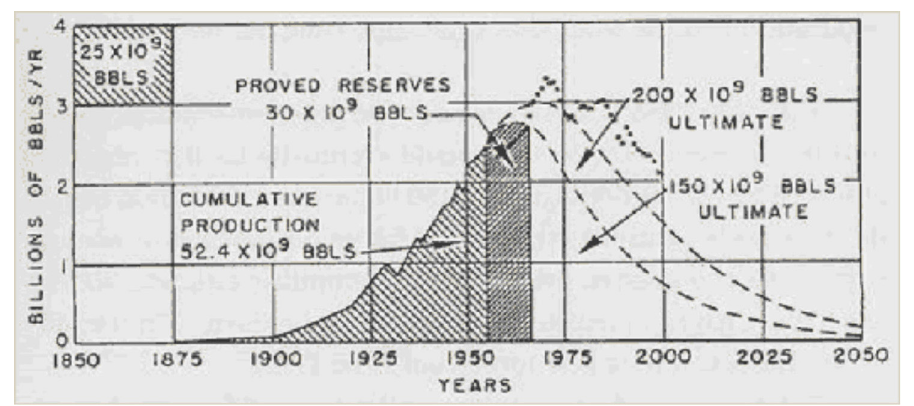
Fig. 11. – Picture taken from “Nuclear energy and the fossil fuels”, M. King Hubbert, June 1956, showing the forecast of the United States overall petroleum